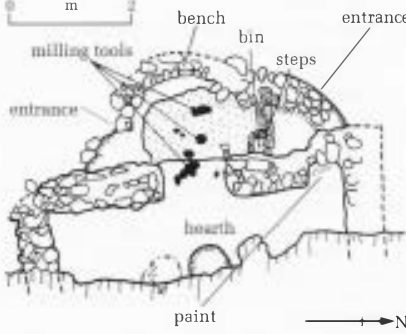
Figure 4 A Middle PPNB house porch at 'Ain Ghazal, Jordan (redrawn from Rollef­ son Simmons 1984, n. fr